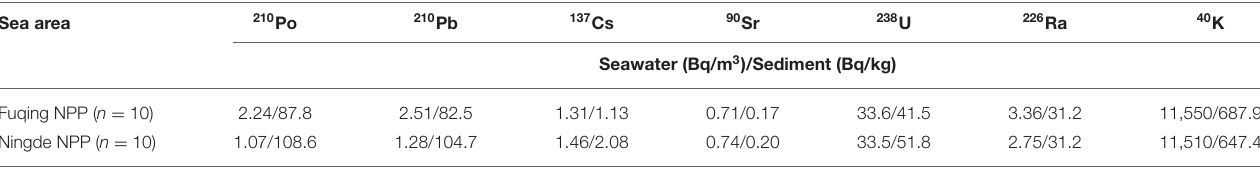
TABLE 3 | Average activities of 210 Po and 210 Pb and other radionuclides in seawater/sediment.